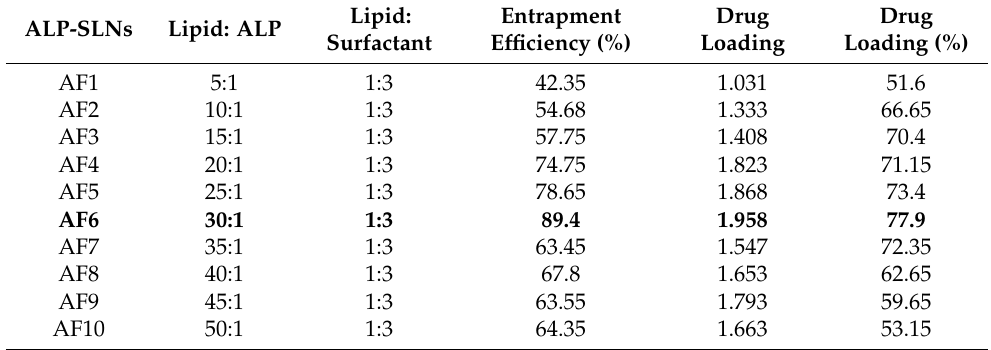
Table 2. Formulation chart for alprazolam loaded SLNs with Entrapment efficiency and Drug loading.